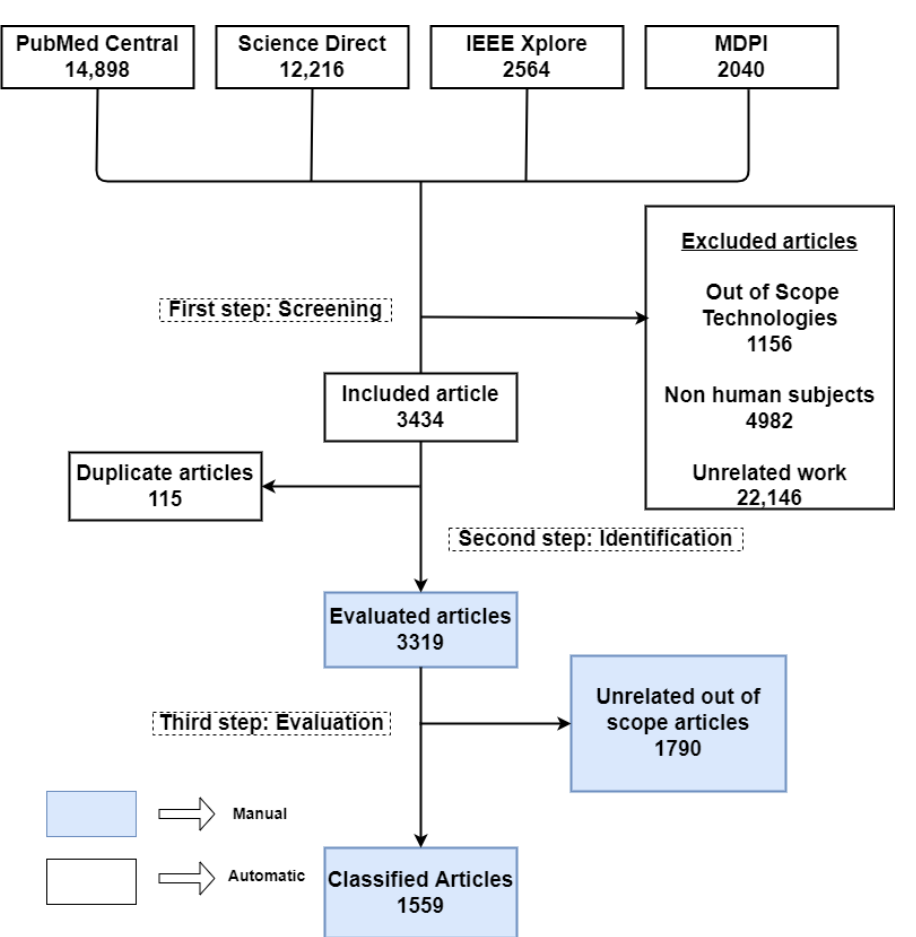
Figure 2. Flow diagram of our systematic review process for PD-assessment research publications